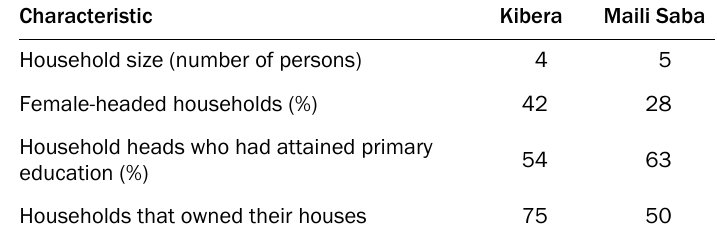
Table 1. Characteristics of the Interviewed